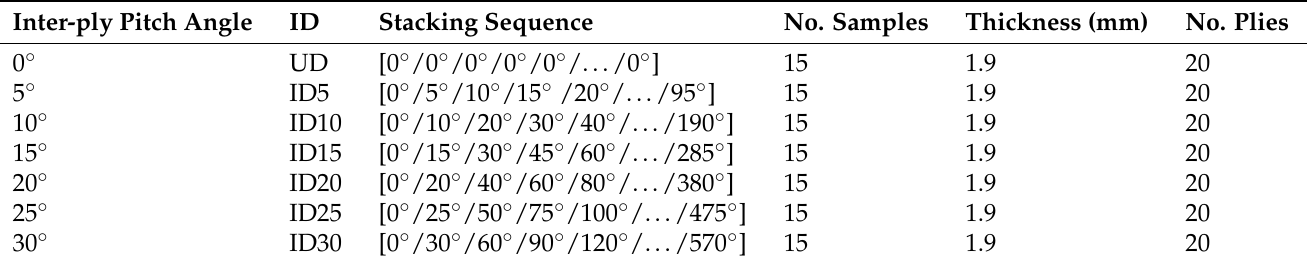
Table 1. Laminate stacking sequences for composite sample sets arranged at specific inter-ply pitch